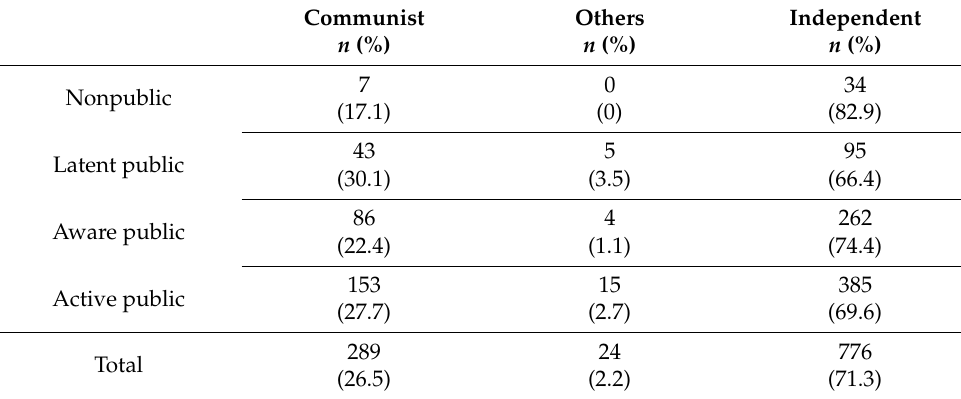
Table 6. Four types of publics and political stance in China.